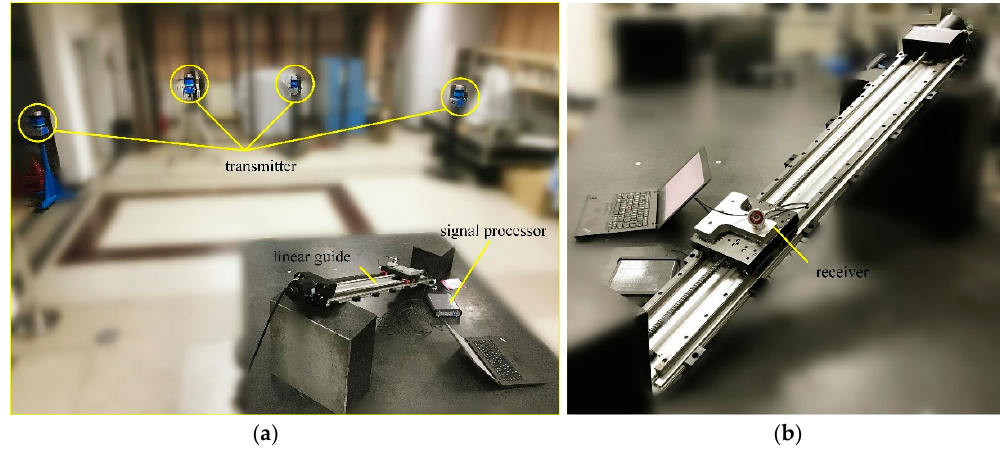
Figure 11. Experiment configuration: ( a ) Overview; ( b ) linear guide and receiver.